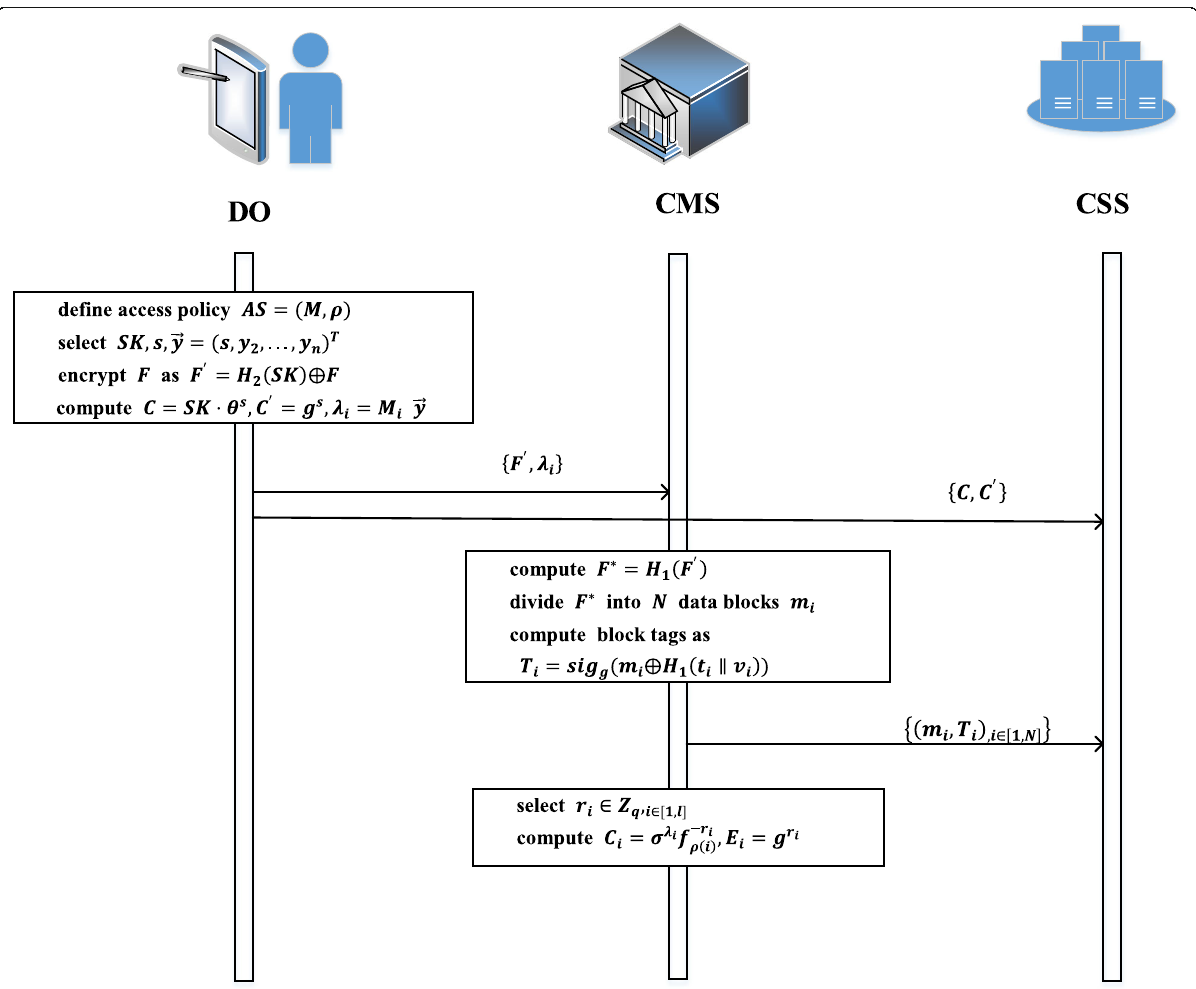
Fig. 3 Data flow of data processing